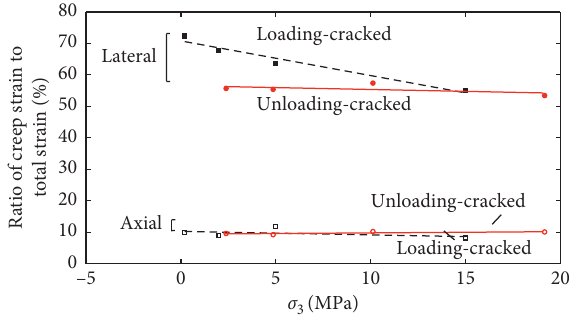
Figure 5: Ratio of creep strain to total